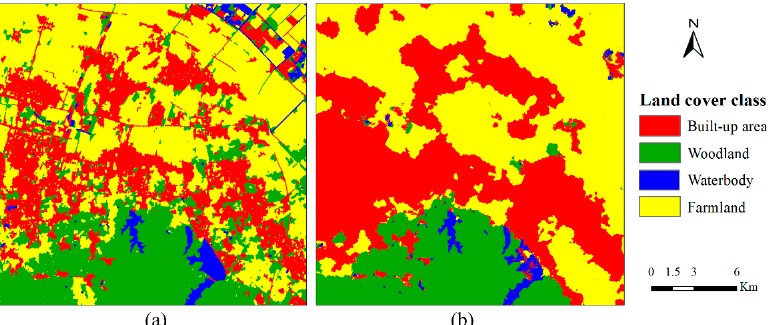
Figure 5. Land use/cover classification results for the Cixi study area: ( a ) pre-classification map; ( b ) MCRF post-classification map. Table 3. Accuracy assessment for pre-classification and corresponding post-classification for the Cixi study area.